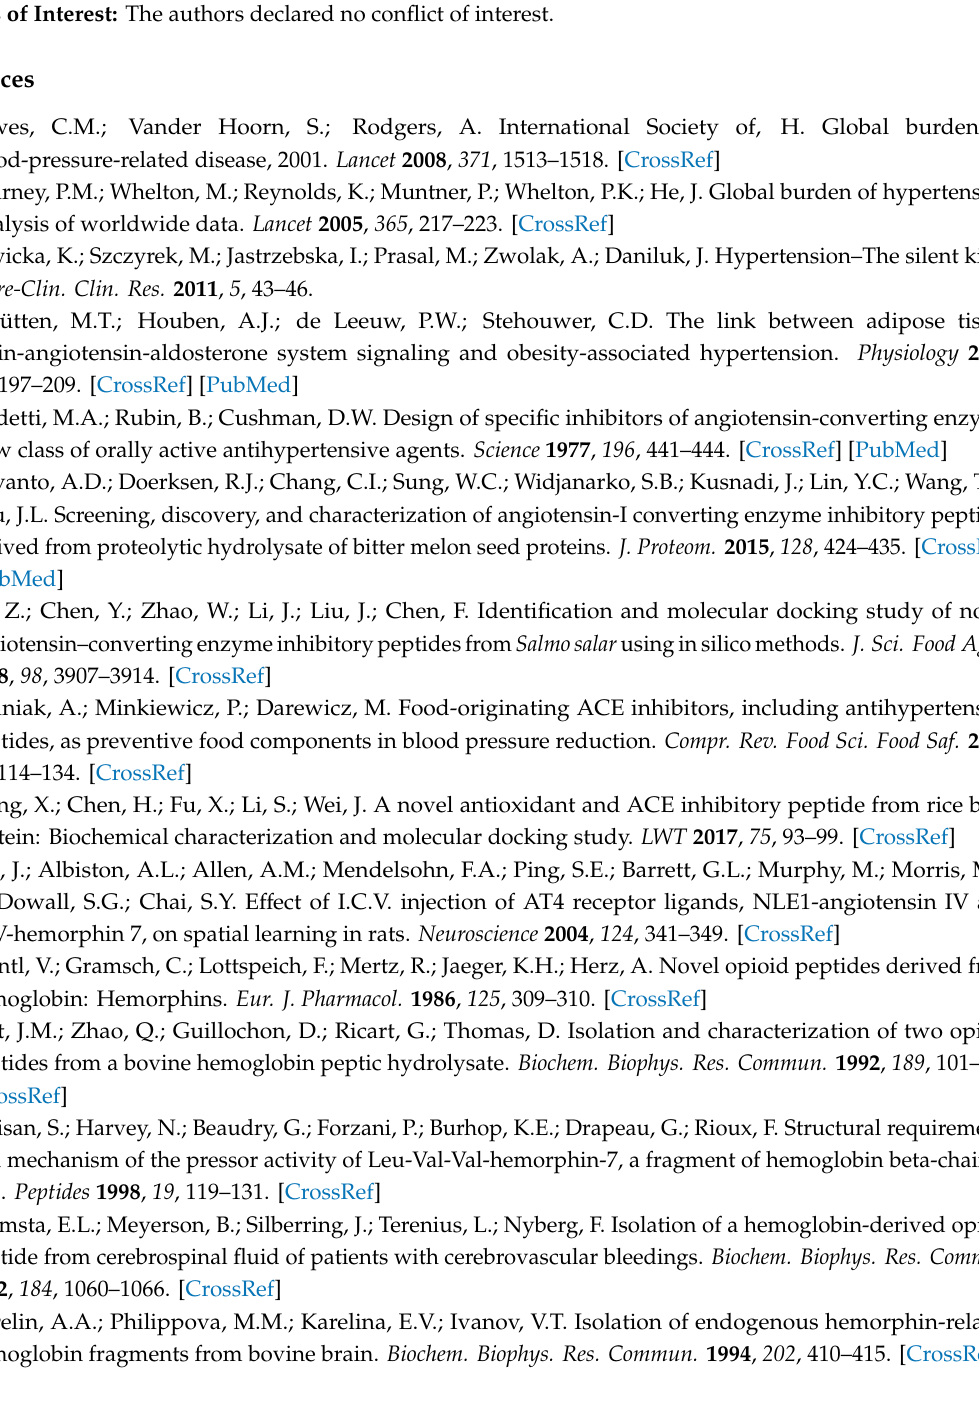
Figure S1: Interactions of LVV-hemorphin-7 with ACE, Figure S2: Interactions of hemorphin-7 with